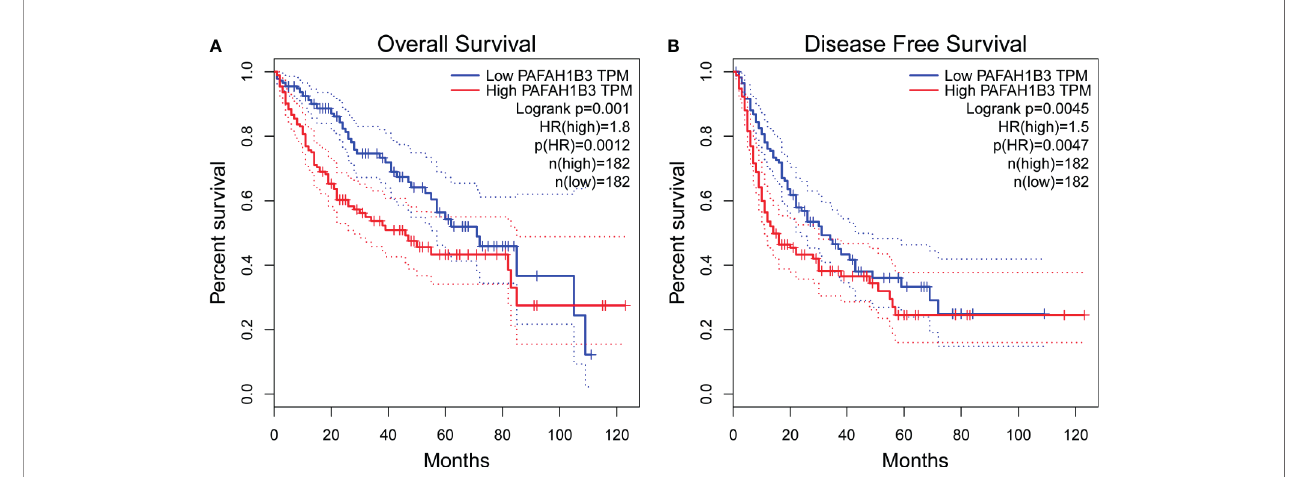
FIGURE 2 | Prognostic Value of PAFAH1B3 in Patients with hepatocellular carcinoma (HCC) (GEPIA). (A) Overall survival (OS) of PAFAH1B3 in HCC. (B) Disease- free survival (DFS) of PAFAH1B3 in